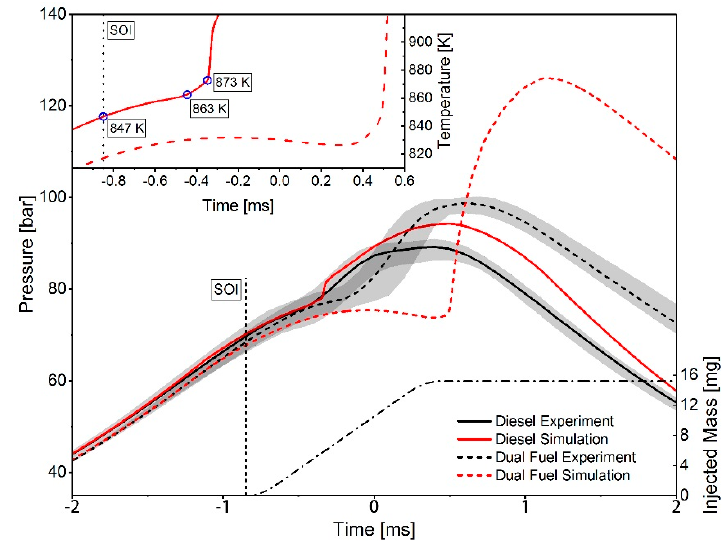
Figure 12. Pressure traces from the computational fluid dynamics (CFD) simulation and measured values from a rapid compression expansion machine (RCEM) for diesel and dual fuel combustion with 20% energetic diesel share. The diagram in the top left corner shows the corresponding simulated temperature traces.